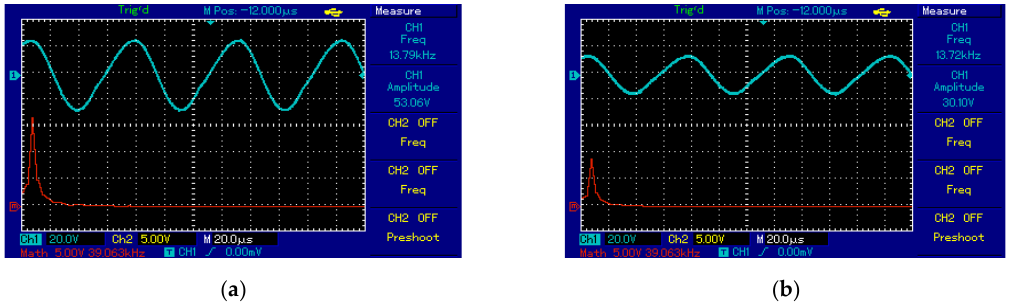
Figure 12. The voltage waveforms using second topology at 7 cm for: ( a ) transmitter coil and ( b ) receiver coil.